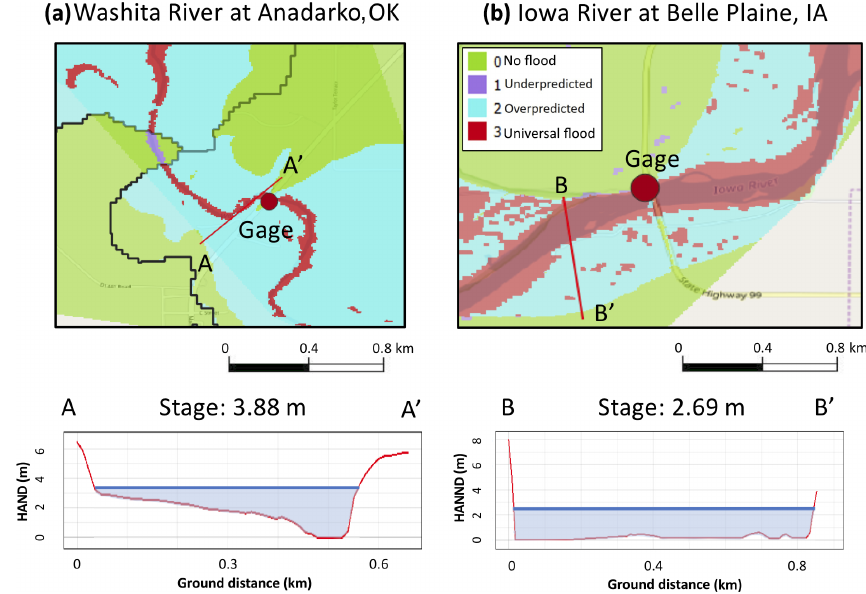
Figure 7. Overprediction in catchments with low relief. (a) This catchment is influenced by a hypersensitive synthetic rating curve relation- ship. (b) This catchment exemplifies a case where the HAND layers will be unable to accurately capture flooding extents due to essentially 0